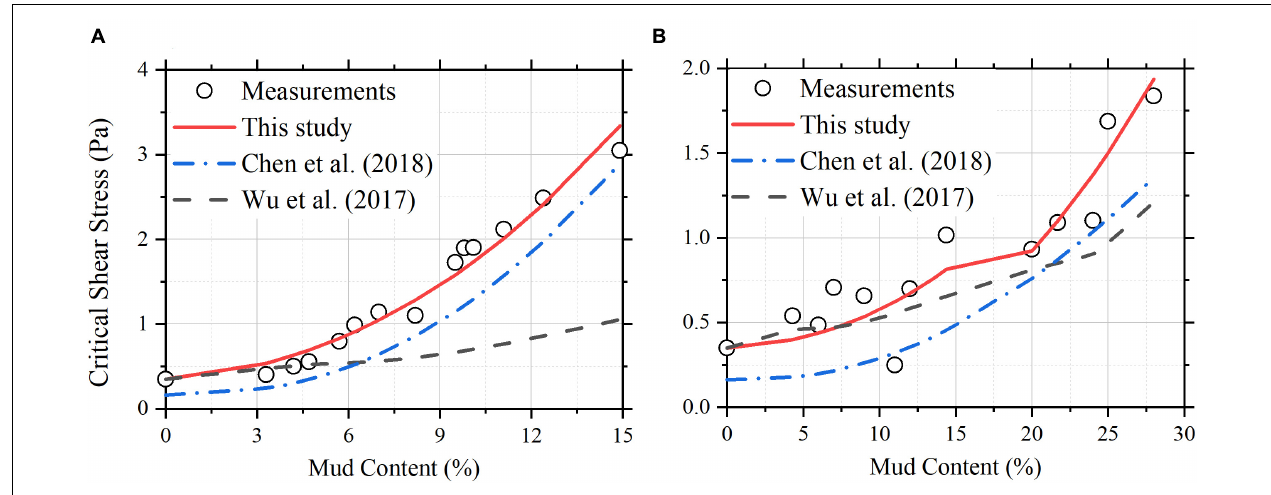
FIGURE 4 | The calculated vs. measured critical shear stresses in the case of Torfs (1995): (A) sand-kaolinite mixtures and (B) sand-montmorillonite mixtures.